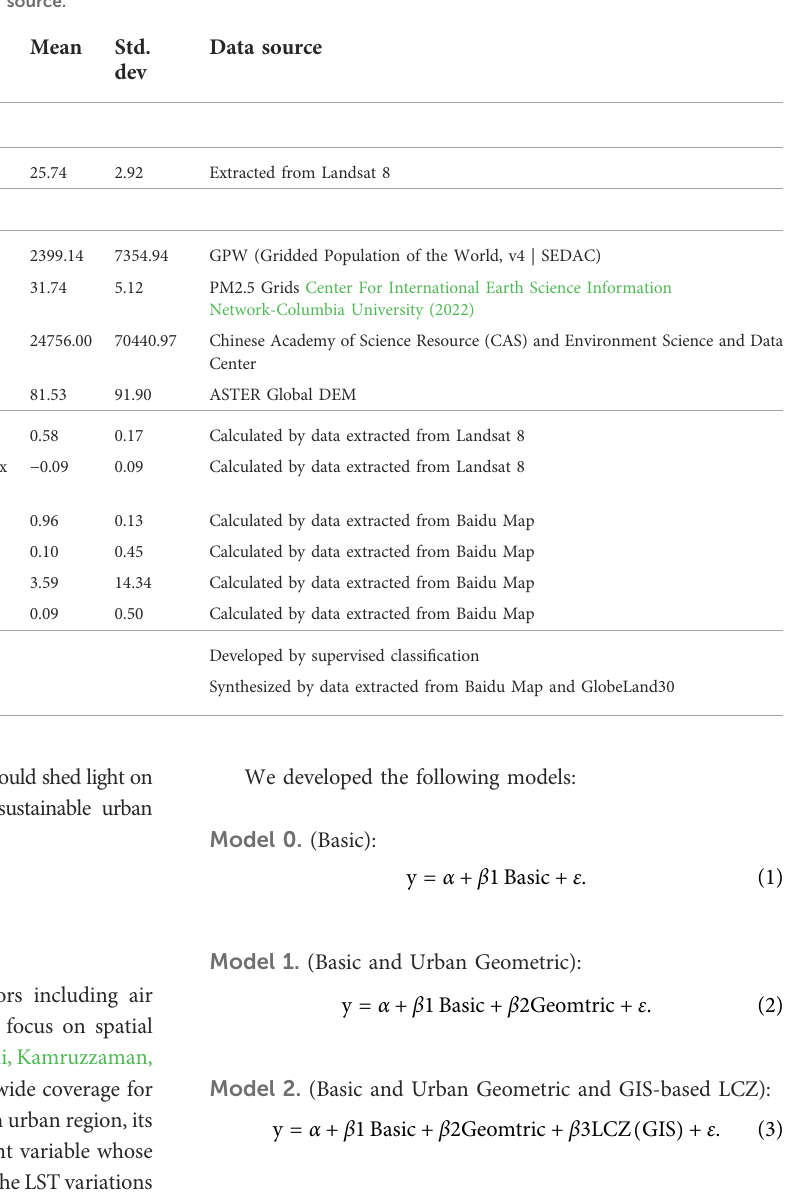
TABLE 1 Descriptive summary of variables and data